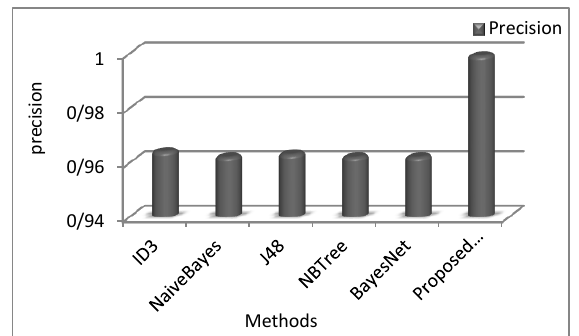
Figure 5. Comparison between proposed method (with 27 trees in decision forest) and basic classification algorithms based on recall.